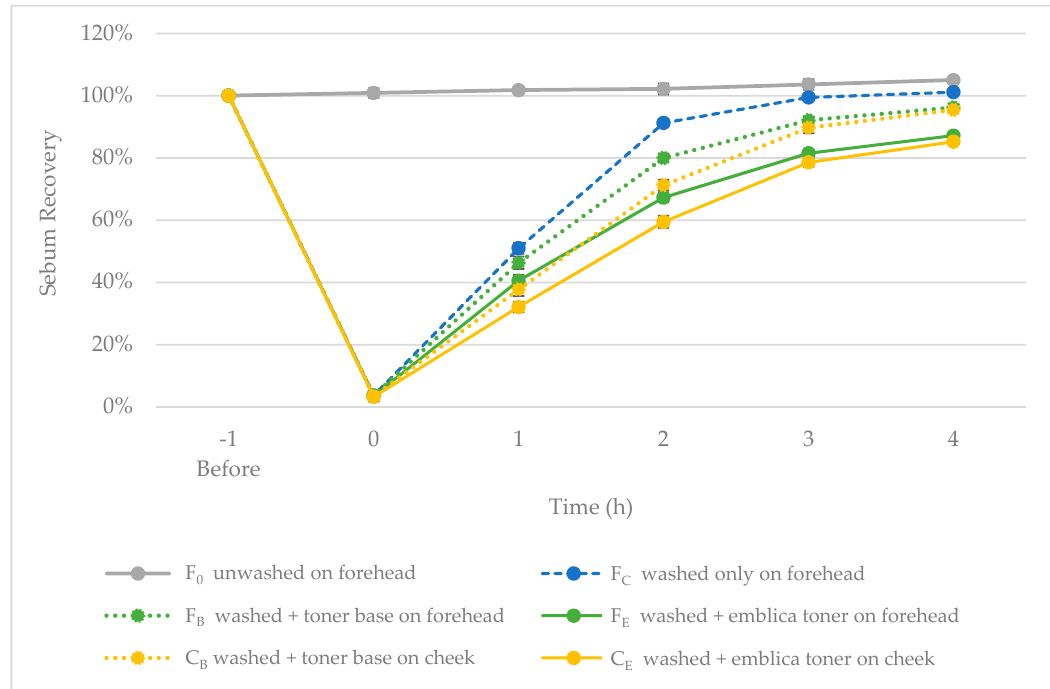
Figure 5. Sebum recovery of various facial skin positions, with designated methods of treatment at different periods, of 30 volunteers.